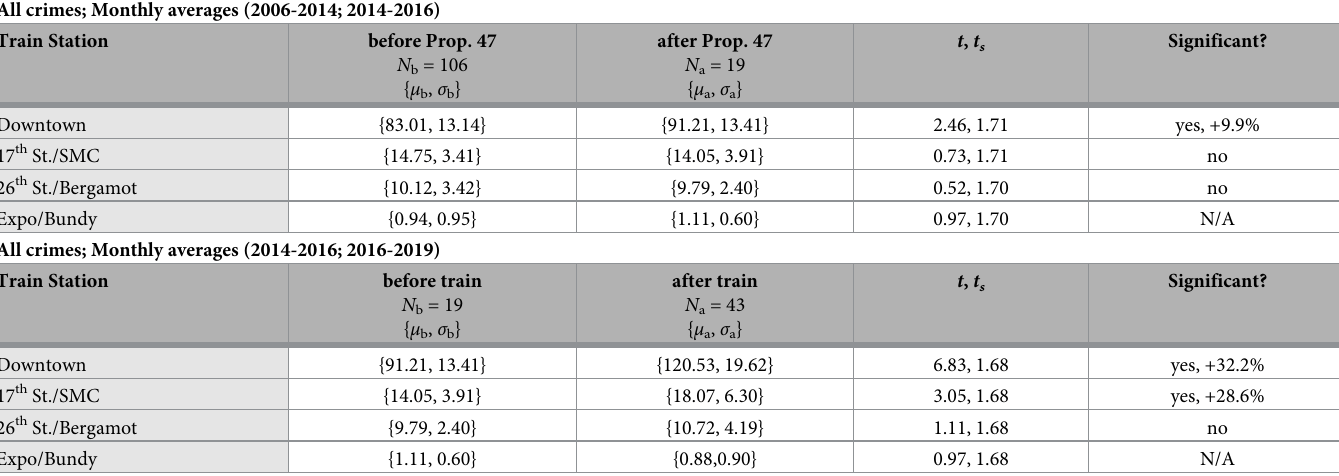
Table 4. Statistical tests on reported crime in the vicinity of light rail station locations in Santa Monica, CA, during three successive time periods spanning 2006– 2019. All crimes; Monthly averages (2006-2014; 2014-2016)